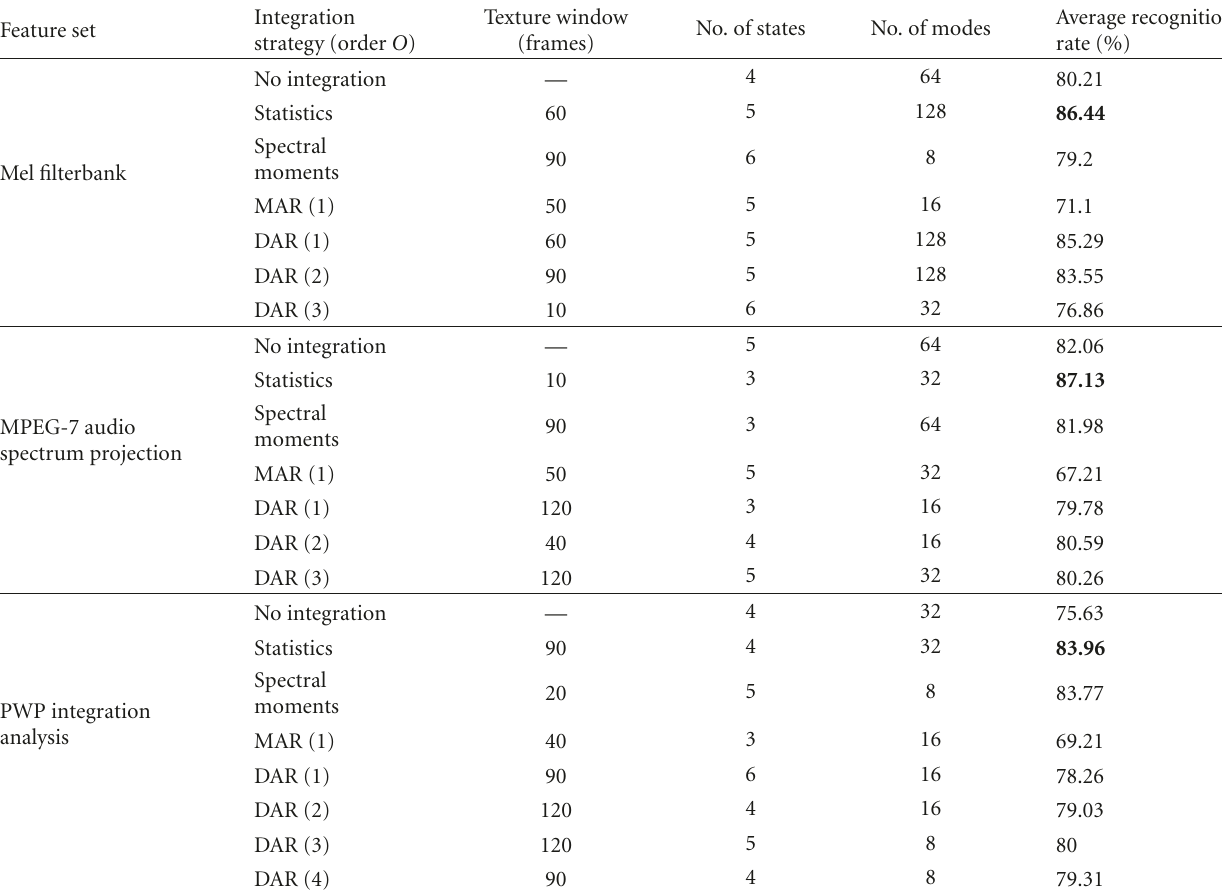
Table 3: System’s performance with respect to each feature set and the integration window with the best